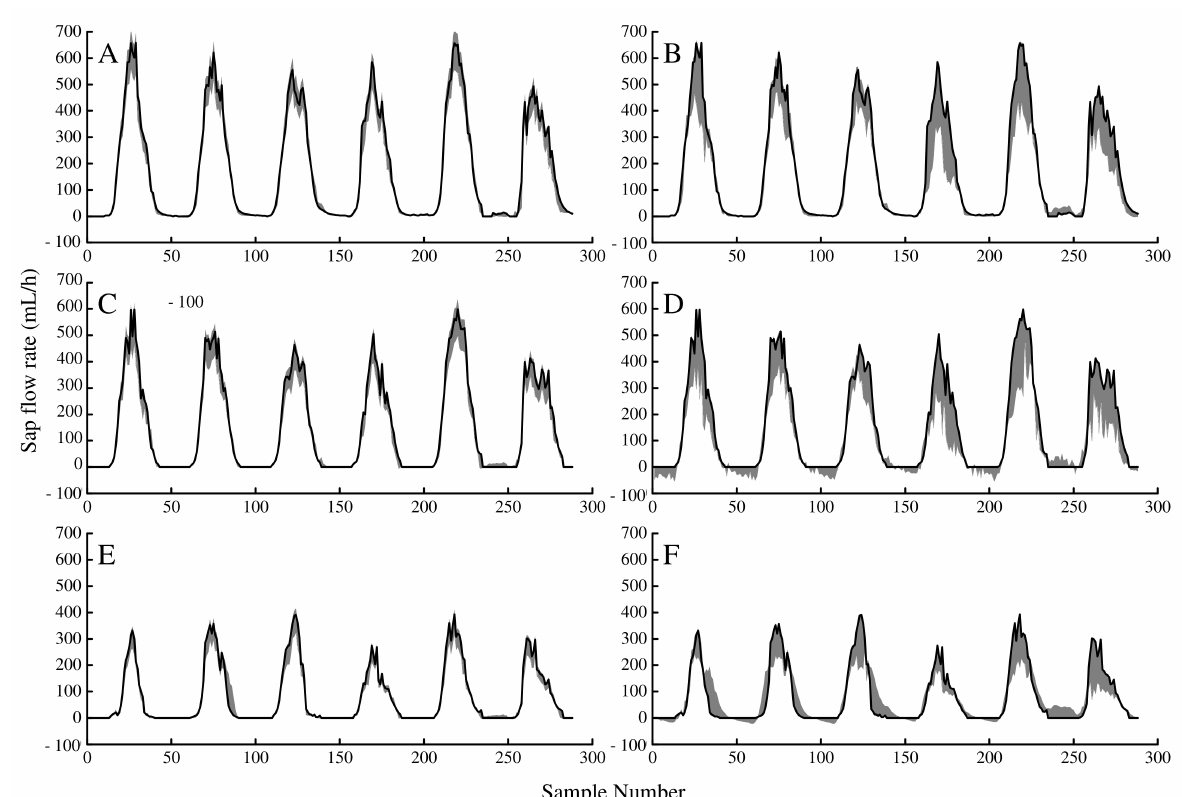
Figure 5. ( A ) The uncertainty analysis for the RF model in the W1 treatment during the fruit expansion stage; ( B ) uncertainty analysis for the PLS model in the W1 treatment during the fruit expansion stage; ( C ) uncertainty analysis for the RF model in the W2 treatment during the fruit expansion stage; ( D ) uncertainty analysis for the PLS model in the W2 treatment during the fruit expansion stage; ( E ) the uncertainty analysis for the RF model in the W3 treatment during the fruit expansion stage; ( F ) uncertainty analysis for the PLS model in the W3 treatment during the fruit expansion stage. The black solid line is the measured sap flow value; the shaded area is the 95% confidence